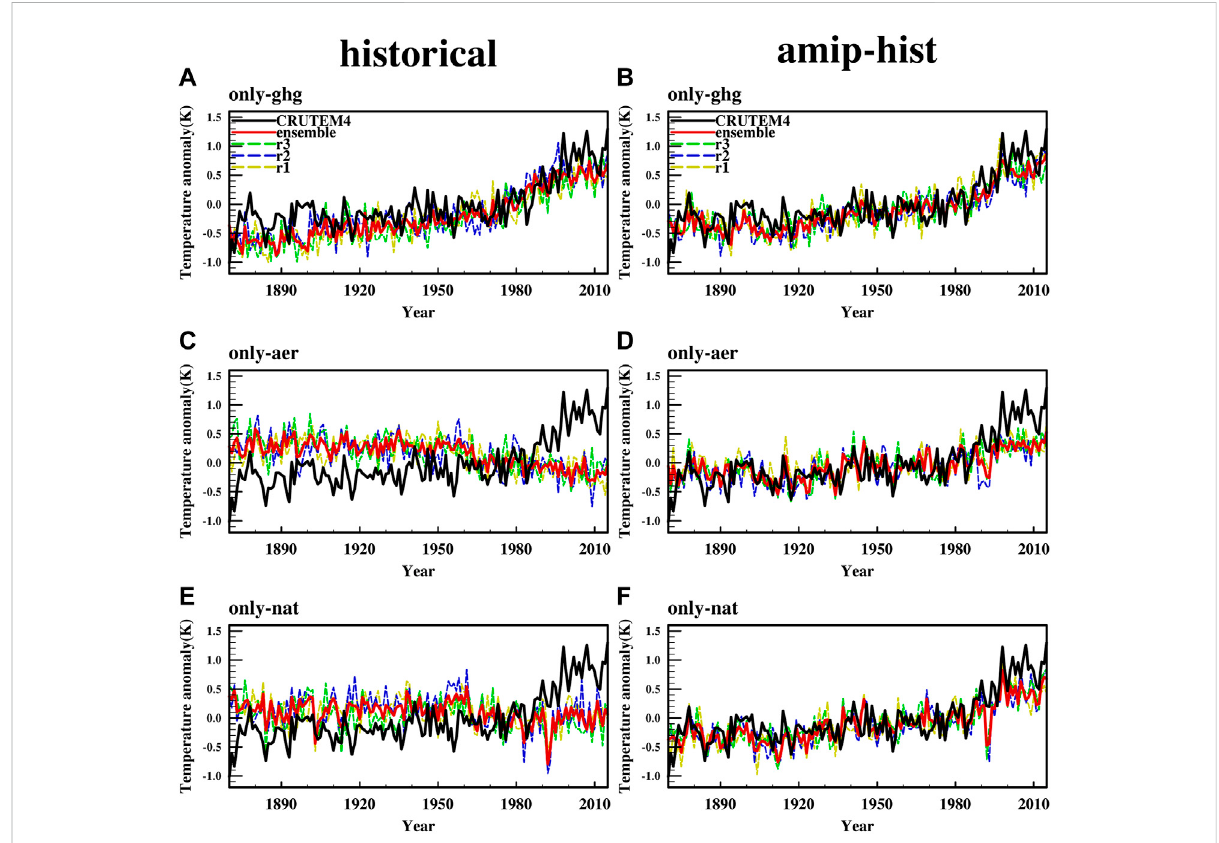
FIGURE 4 Same as Figure 2, but for the simulations with solely time-varying of (A,B) GHG forcing, (C,D) aerosol forcing, and (E,F) natural forcing (units: K; relative to 1961 – 1990 mean). The left column is for the coupled model (FGOALS-g3) and the right column is for the uncoupled model (GAMIL3). Black line: CRUTEM4; red line: ensemble